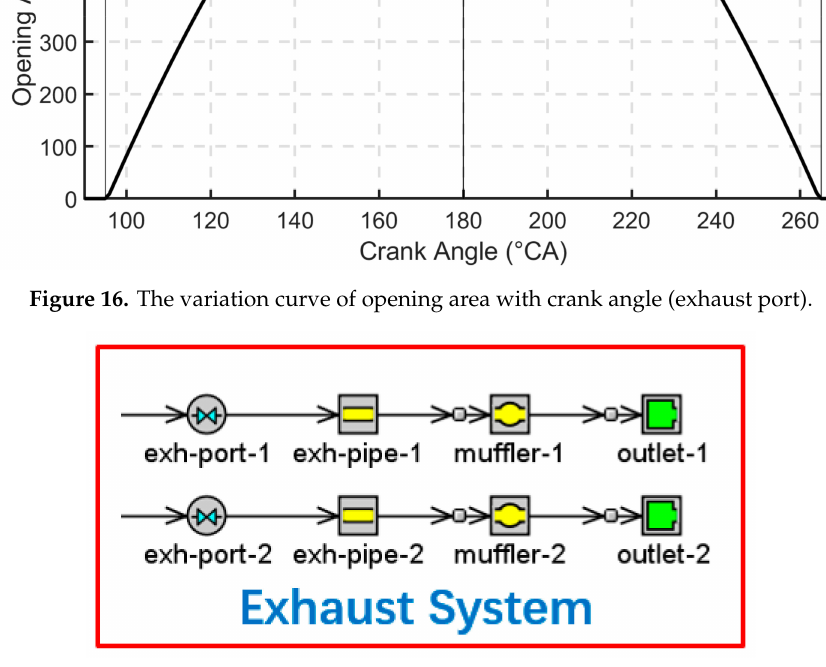
Figure 17. The layout of exhaust system in